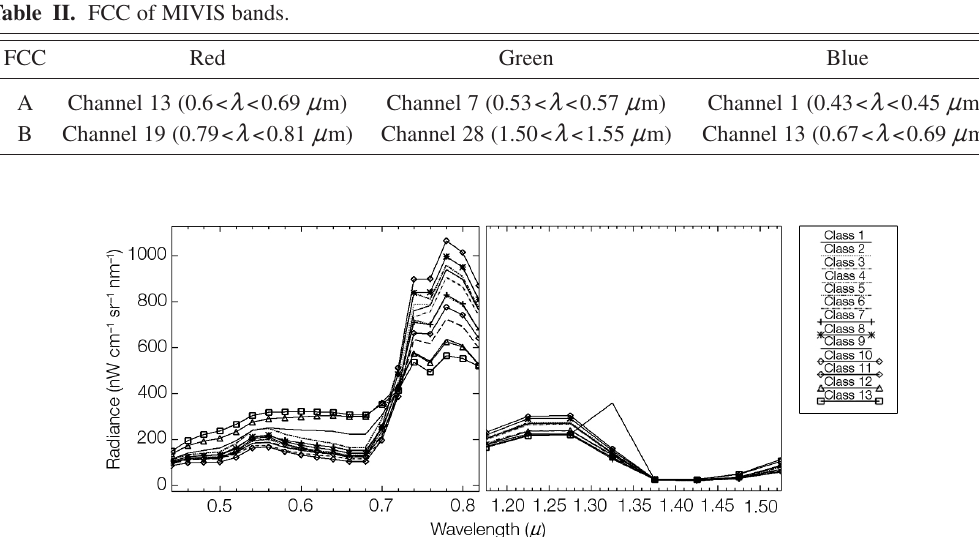
Fig. 2. MIVIS at sensor radiance mean spectra of the 13 Region Of Interest (ROI) relative to the natural envi- ronment land cover classes.